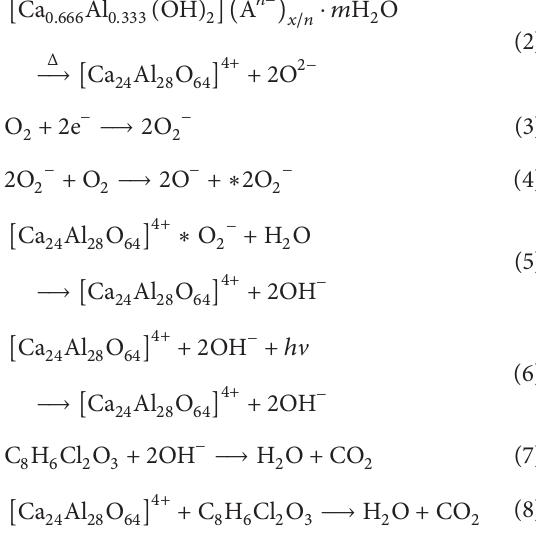
therefore, a reaction mechanism is proposed (see Figure 11 and